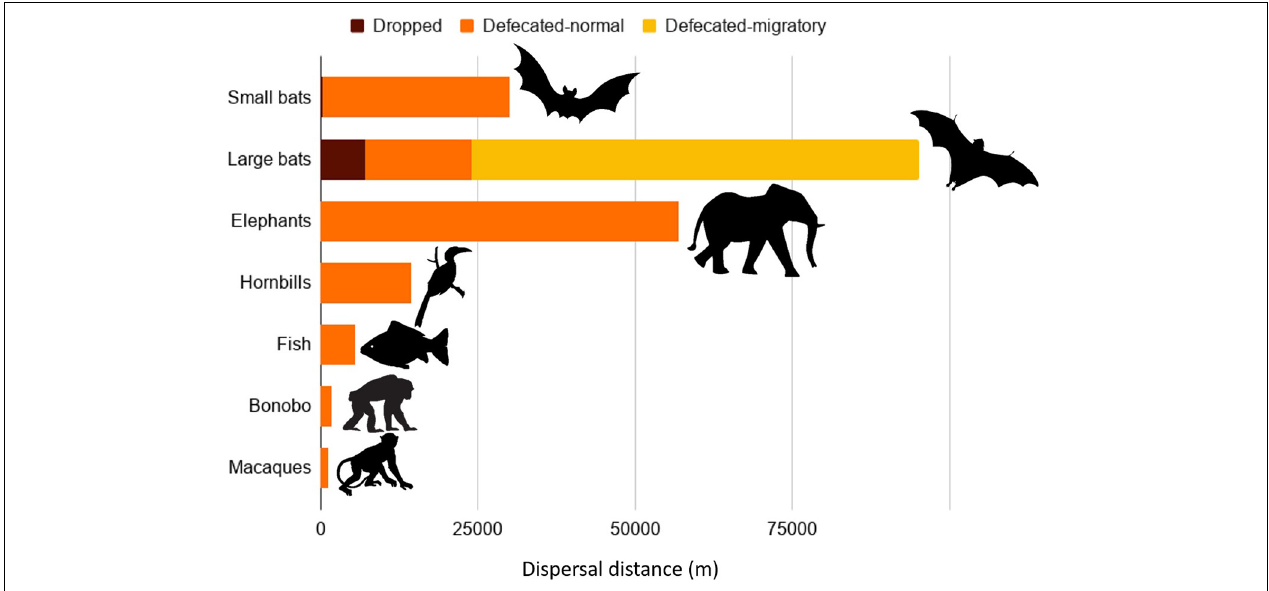
FIGURE 4 | Maximum seed dispersal distances for small ( < 250 g) and large ( ≥ 250 g) pteropodid bats and the comparison with other taxa confirmed to perform long-distance seed dispersal. References for the comparisons are given in the text. Dispersal distances for bats are given for seeds defecated without swallowing (dropped or spat), and defecated seeds during migratory and non-migratory